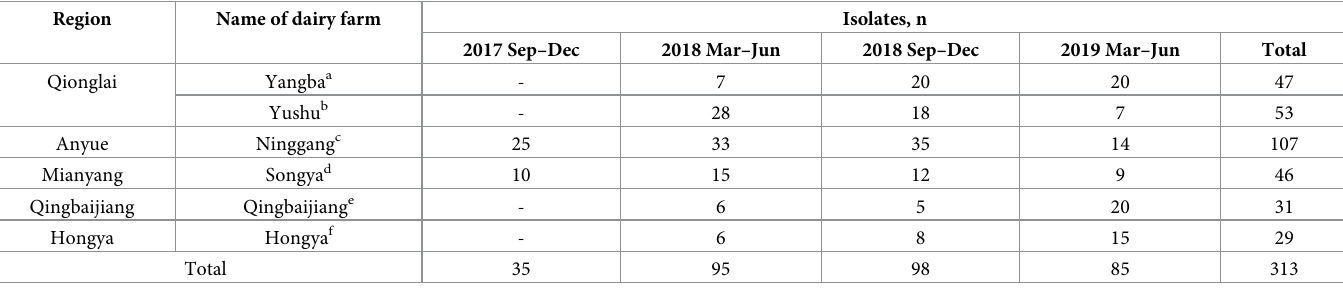
Table 1. Geographic distribution of samples collected in this study. Region Name of dairy farm Isolates,